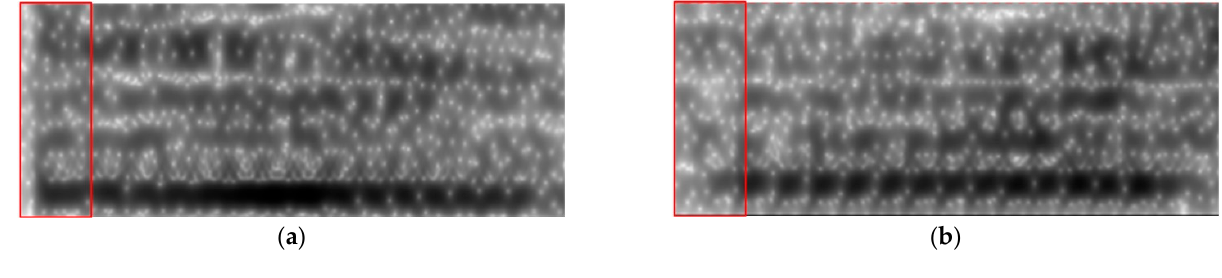
Figure 3. Spectrograms of different speakers pronouncing ai .